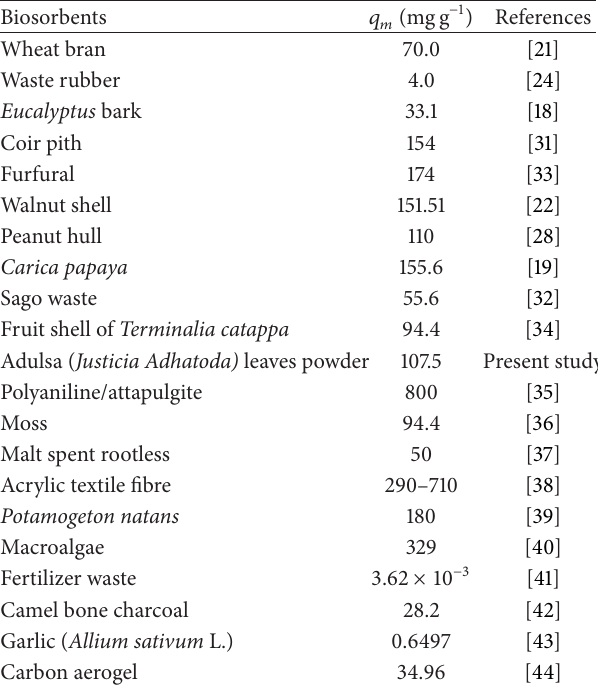
Table 3: Comparison of monolayer maximum adsorption capacity of Hg(II) ion with various